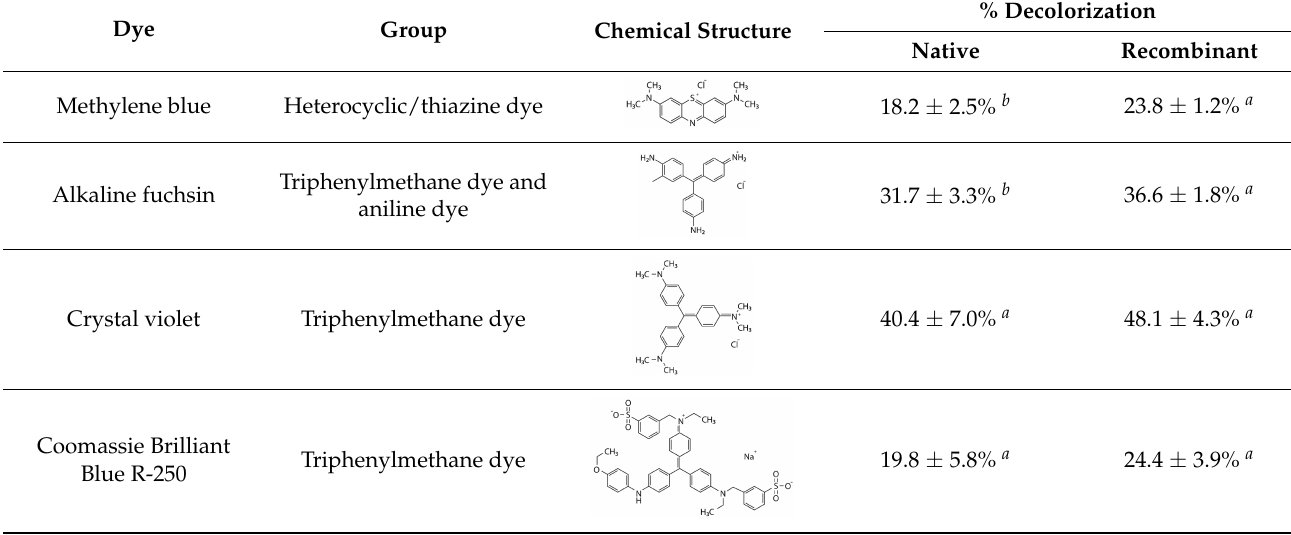
Table 4. Decolorization of the synthetic dyes using native laccase G3 [29] and purified recombinant laccase KbLcc1 from Kabatiella bupleuri G3 IBMiP expressed in Pichia pastoris ; reaction mixture contained 0.1 U of laccase, 250 mg/L of synthetic dye and 1 mM of ABTS as a redox mediator; the data presented as the means ± SD from at least three independent experiments; the means that are marked with different letters ( a – b ) are significantly different ( p < 0.05).